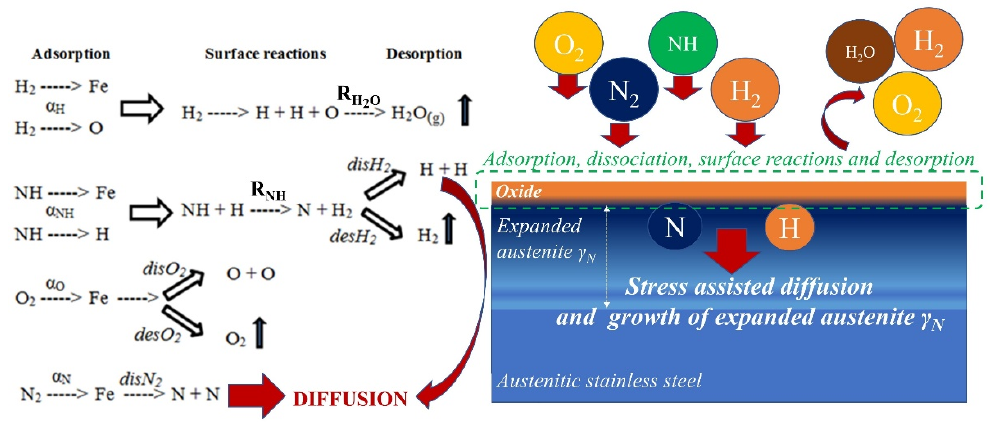
Figure 1. Schematic presentation of the elementary processes taking place during plasma nitriding.